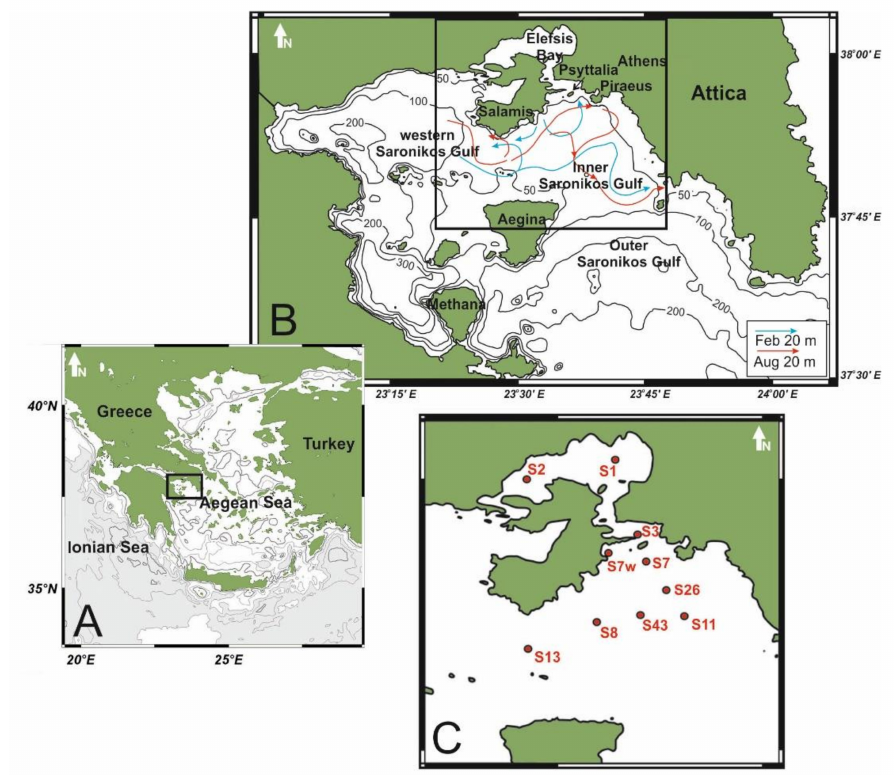
Figure 1. ( A ) Location map of the study area; ( B ) Topography and bathymetry of the Saronikos Gulf with generalized circulation pattern (based on data from Kontoyiannis [51]); ( C ) location of the sampled station.